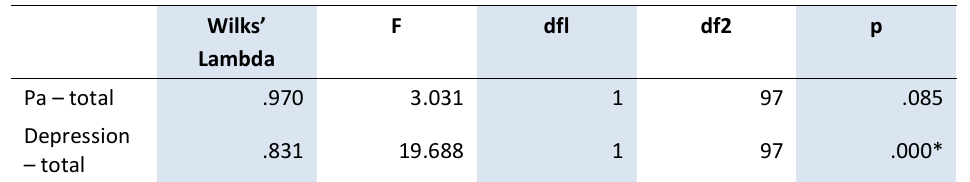
Table 12: Testing of the equivalence between the group means